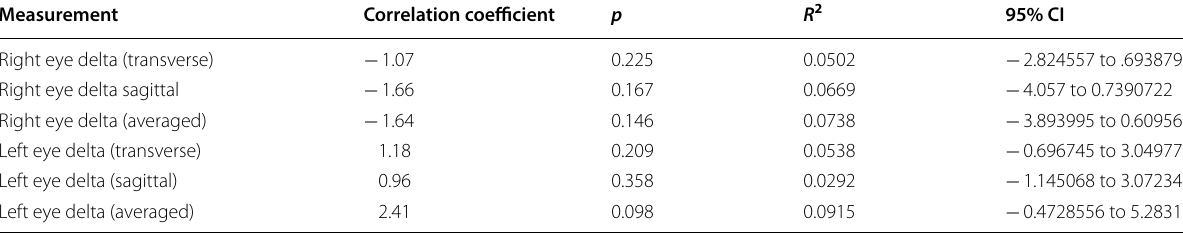
Table 5 Linear regression analysis of ONSD measurements to volume of CSF removal Measurement